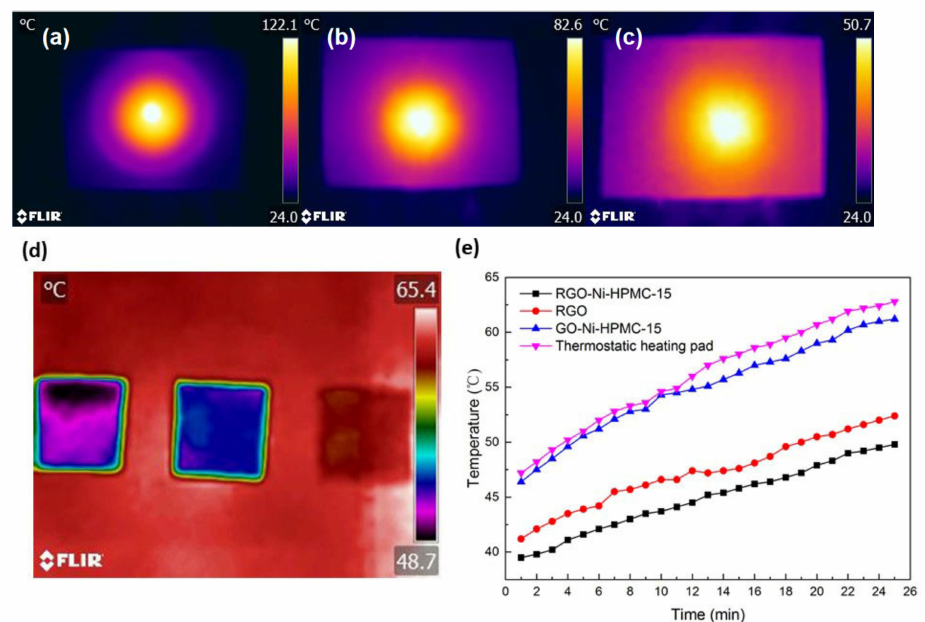
Figure 5. ( a ) Schematic diagram of thermal conductivity of GO-Ni-HPMC-15 composite film; ( b ) Schematic diagram of heat conduction performance of RGO film; ( c ) Schematic diagram of thermal conductivity of RGO-Ni-HPMC-15 composite film; ( d ) Heat dissipation diagram of analog electronic equipment; ( e ) Surface temperature and time variation of RGO-Ni-HPMC-15 composite